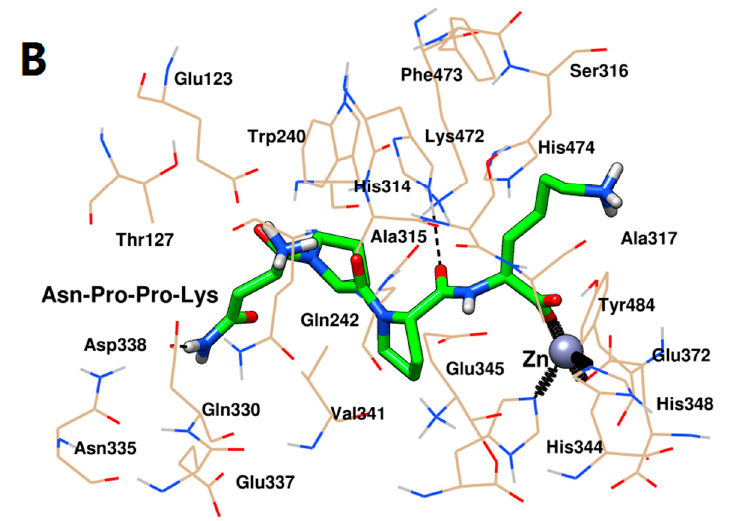
Figure 11. Molecular dynamics conformation of Ile-Ile-Tyr ( A ) and Asn-Pro-Pro-Lys ( B ) with ACE. Gold lines represented the ACE residues involved in interacting with peptides. Green sticks represented the peptides. Grey sphere represented the Zn(II). Black dash lines represented the hydrogen bonds. Black springs represented the coordination bonds.